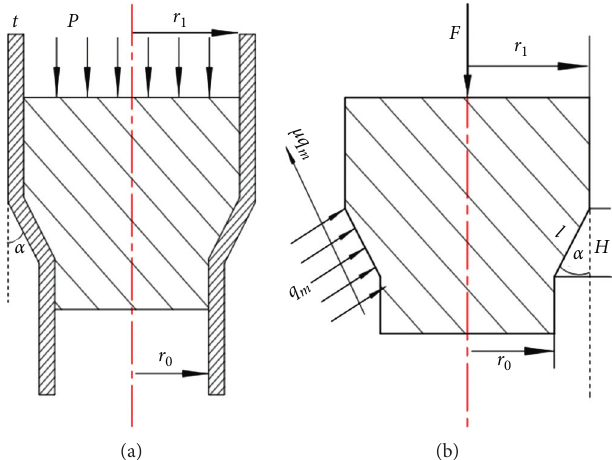
Figure 3: Mechanical equilibrium model of expansion inside the hanger.